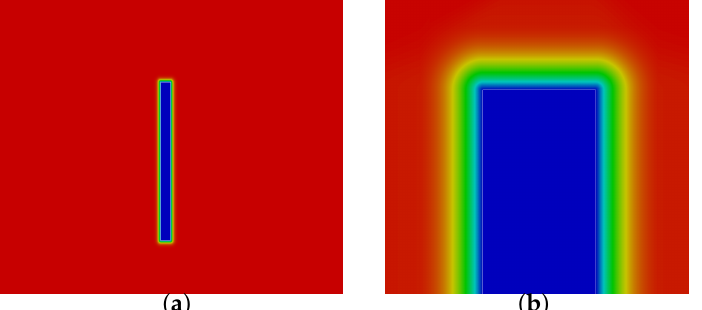
Figure 4. ( a ) Interface function for a test case featuring one actuator disc, and ( b ) closeup to the top of the disc. The range of the interface function is [0, 1].